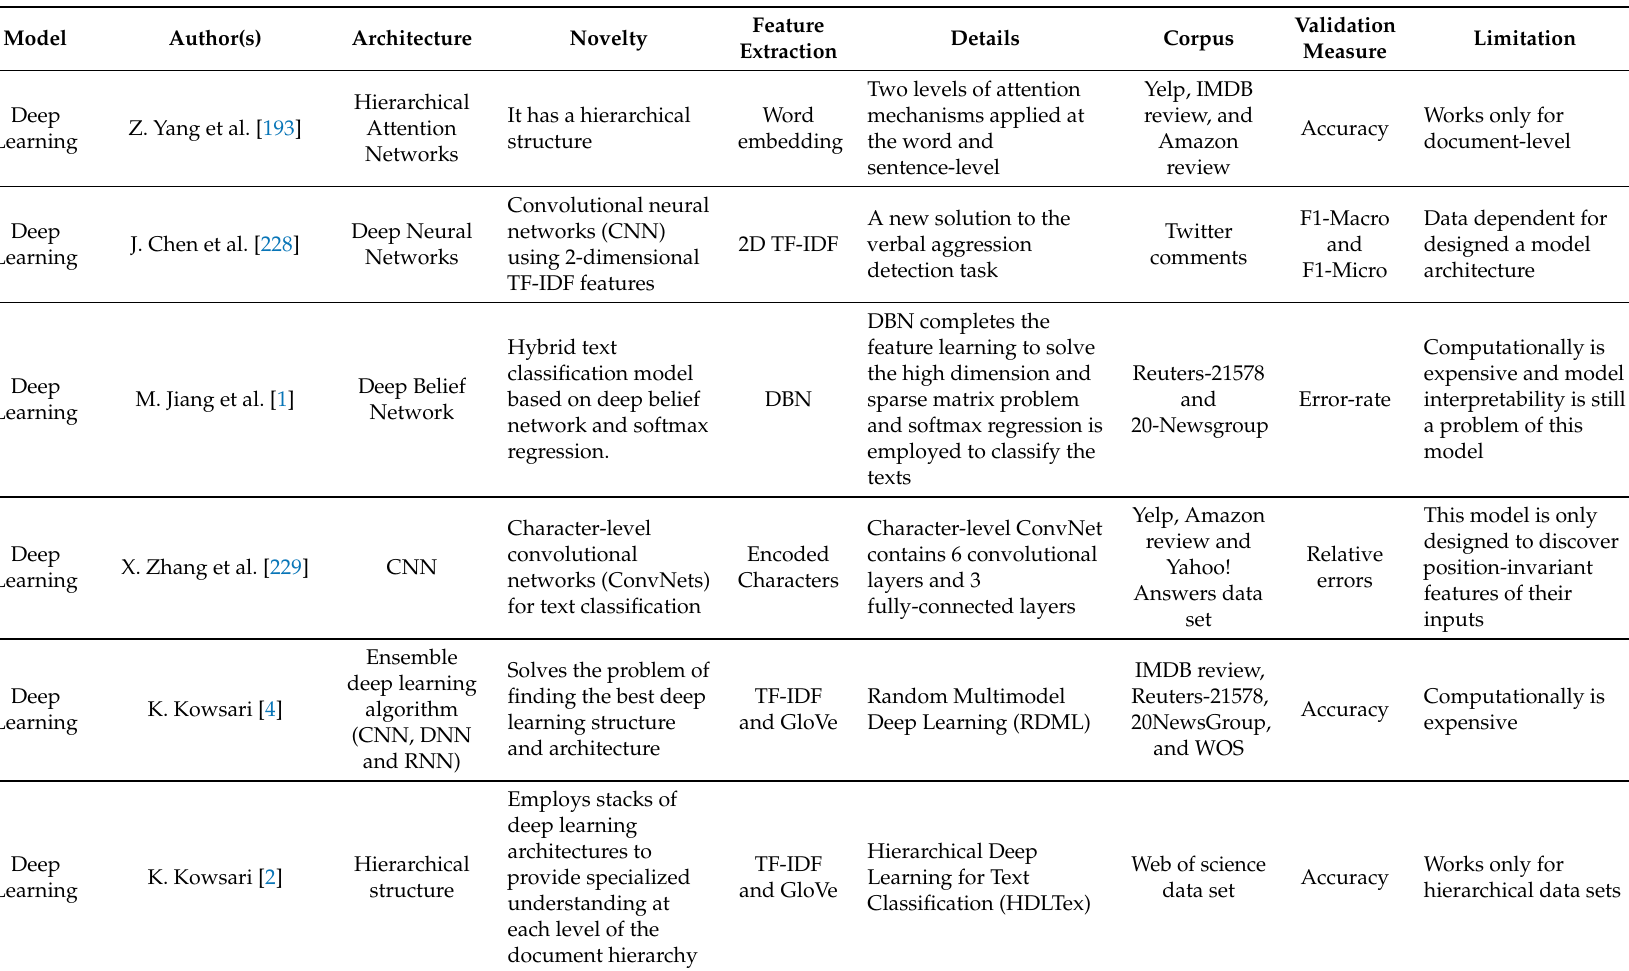
Table 5. Comparison of the text classification techniques